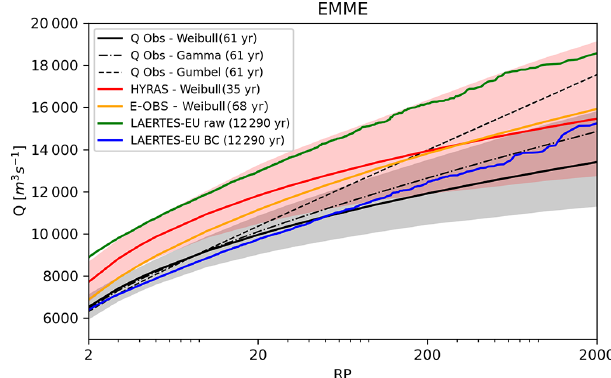
Figure 7. Return values of observed and simulated discharges Q at EMME station. Given are the Weibull (solid black), Gumbel (dashed black), and gamma (dot-dashed black) distributions for ob- served discharges as well as the Weibull distributions for the sim- ulation forced with observed precipitation from E-OBS (orange) and HYRAS (red). The results from uncorrected LAERTES-EU- driven simulations are given in green, and those driven by corrected LAERTES-EU data are shown in blue. The shaded areas represent the 95% confidence intervals of HYRAS (red) and Q Obs-Weibull (gray). The length of each time series is given in the